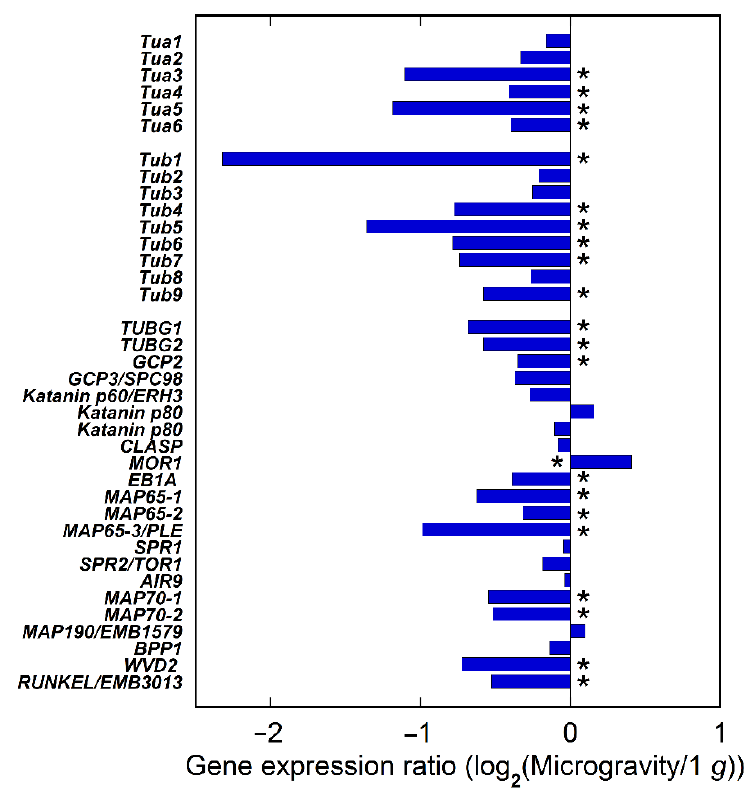
Figure 5. The effect of microgravity on expression of α -tubulin, ß-tubulin, and MAPs genes in the apical region of inflorescence stems in tua4 mutant. The gene expression was shown as the ratio of expression under microgravity conditions to that of the on-orbit control. *, Mean values with significant differences between the on-orbit control and microgravity ( n = 3, p < 0.05).